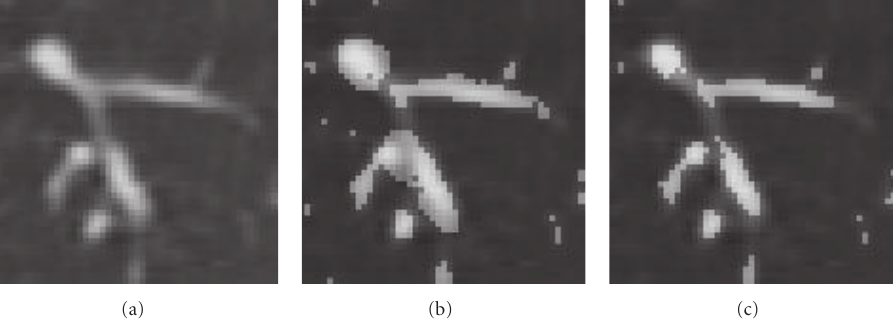
Figure 3: Segmentation results by thresholding the filter output with a fixed value ( − 600 [H.U.]). (a) Original CT image visualized using a √ √ 2,2,2 2,4 } is used for all voxels. (c) (2) is used to determine S . In (b), window of 1500 H.U. at the level of − 400 H.U. (b) A fixed S = { 1, nonvessel regions around a junction are also extracted as vessels whereas segmented regions reside within the visible vessels in (c). It should be noted that while vessel segments do not appear to be connected in this image, they are connected in the neighboring slices. In the event that they were not connected, the local disconnections would be fixed by the tracking process described in Section